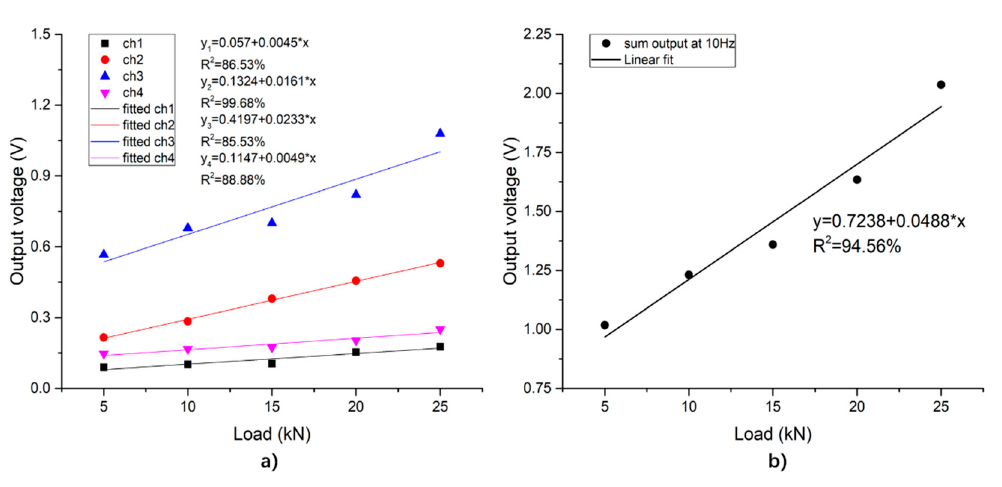
Figure 15. Relationship between the peak-to-valley value of the output voltage of the system with di ff erent loading amplitudes. ( a ) The output of each piezoelectric unit; ( b ) the total output of the sensing system.